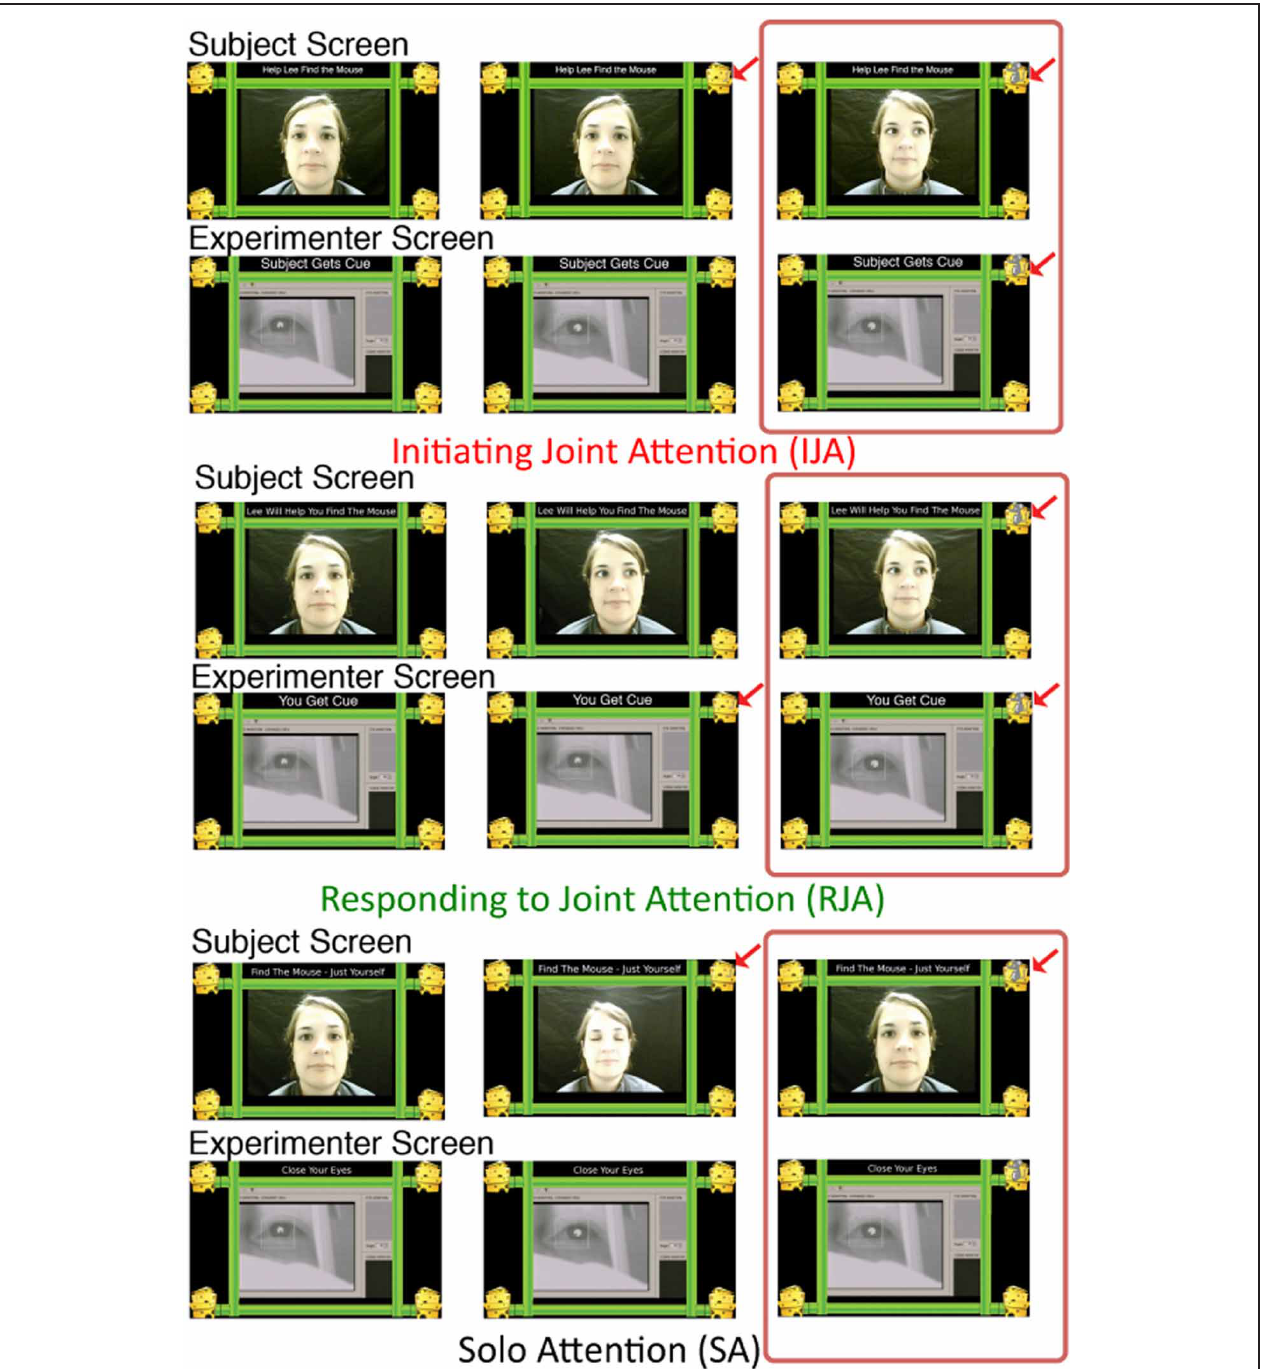
FIGURE 1 | Joint attention task. During fMRI data acquisition, participants viewed a live video feed of the experimenter with four “mouse houses” connected by pipes surrounding the experimenters face (Subject Screen). The experimenter viewed the same houses and pipes with a live video feed of the participant’s eye in the center of her screen (Experimenter Screen). During initiating joint attention, the mouse tail appeared only on the Subject Screen over one of the four mouse houses (middle panel). The participant shifted gaze to the correct location and when the experimenter followed the mouse appeared (right panel). Responding to joint attention was similar